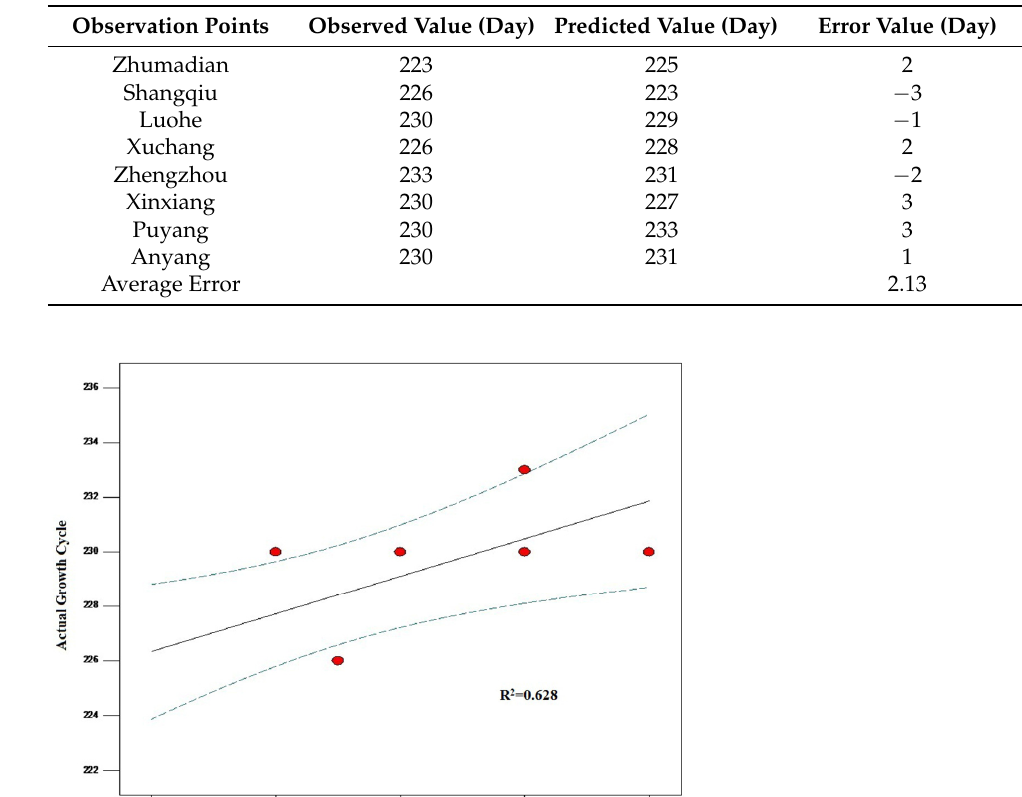
Table 11. Comparison of observed and forecasted values of harvesting winter wheat in Henan province in 2021.